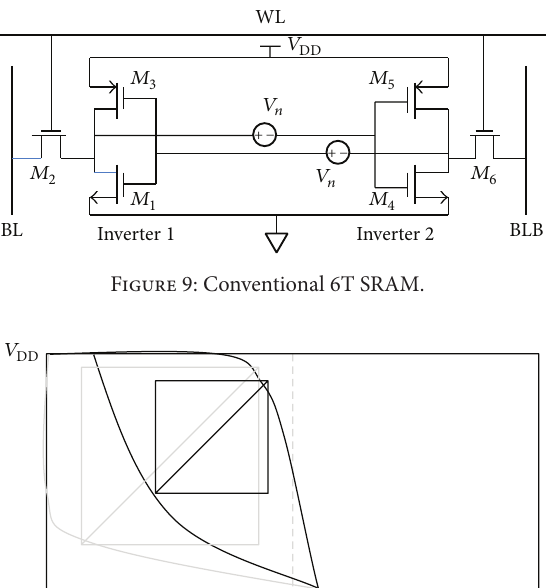
BLB do not influence the potentials at point Q and point